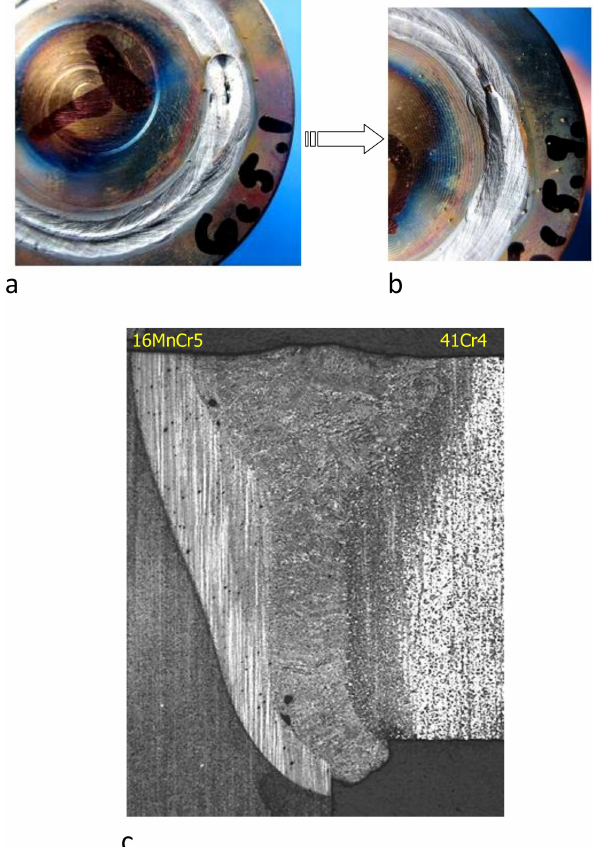
Figure 11. Modified laser welding set-up resulting in improved weld profile. ( a ) Shows the top weld profile at end of the weld, with eight tack welds, but no downslope strategy for the welding power; ( b ) the top weld profile at the end of the weld with a ‘downslope’ strategy with 55 ◦ overlap, gradually reducing the welding power from 4–0 kW and moving the reference point from Z f : 0–4 mm. ( c ) micrograph of the weld cross section for the 16MnCr5-41Cr4 material